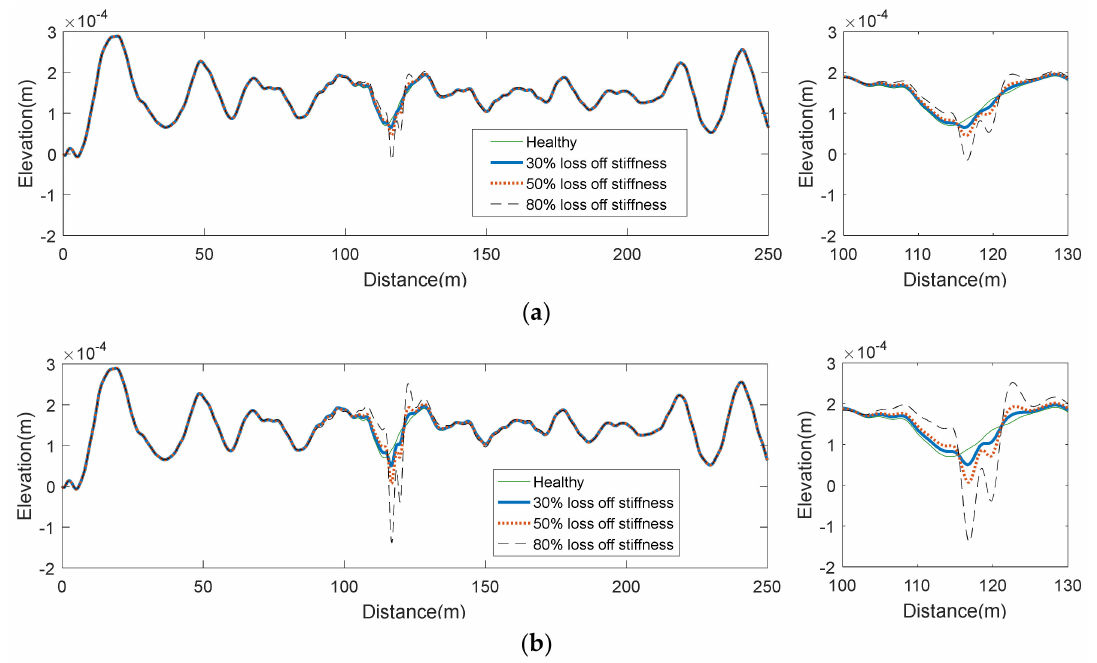
Figure 14. The mean of BFDs for the healthy and damaged tracks, ( a ) for one damaged sleeper, ( b ) for two damaged